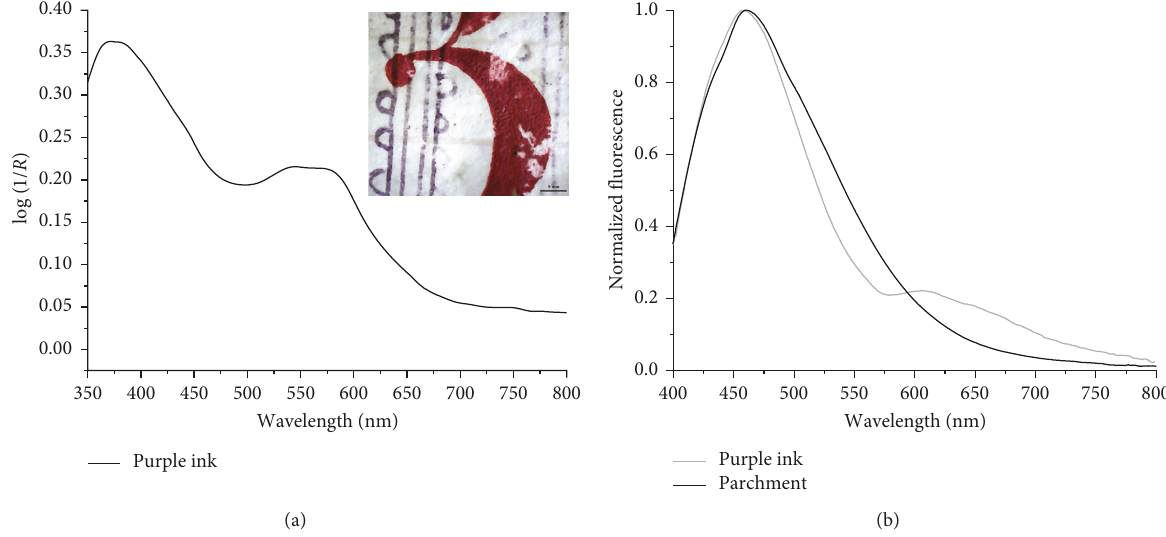
Figure 6: Reflectance spectrum in log (1/ R ) coordinates of the purple lines (shown in the inset, 150x magnification): (a) Parch. 38 and (b) fluorescence spectra of the purple ink and the related